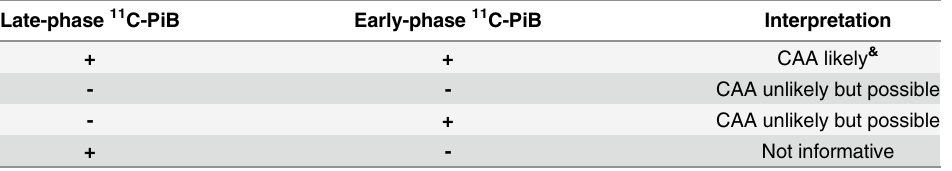
Table 2. Diagnostic paradigm using the combined results from both early- and late-phase whole-cor- tex 11 C-PiB-PET in suspected CAA-related lobar intra-cerebral hemorrhage.